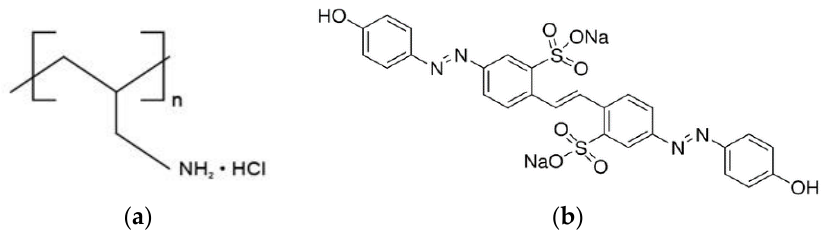
Figure 1. Chemical structures for ( a ) poly(allylamine hydrochloride) (PAH) and ( b ) Direct Yellow 4 (from Sigma Aldrich).